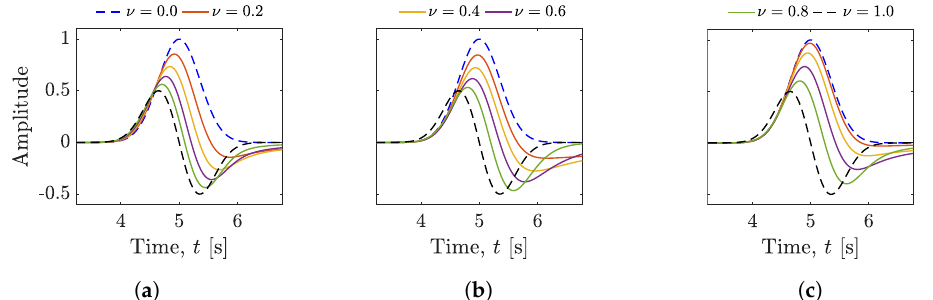
Figure 2. Example of fractional Gaussian windows under the Caputo definition using different kernels and varying the non-integer order ν , with µ = 5 s and σ =